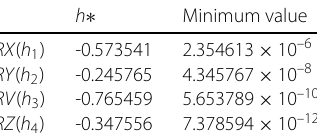
Table 3 The minimum values of RX ( h 1 ∗ ), RY ( h 2 ∗ ), RV ( h 3 ∗ ), RZ ( h 4 ∗ )